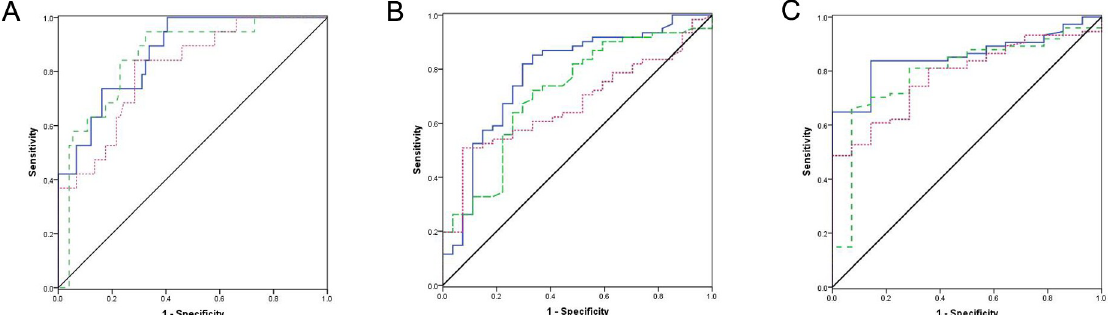
Fig 3. ROC plots express the prognostic value of illness severity of lymphopenia compared with CRP and LDH levels. ROC curves to predict patients with (A) pneumonia of severe grade or critical grade, (B) bilateral lung involvement in lung CT scan, and (C) abnormal lung image on discharge. The diagonal line indicates an AUC of 0.5 (no discrimination between the two states). The blue line indicates CRP level; The green dashed line indicates lymphocyte count; The pink dotted line indicates LDH level. LYM, lymphopenia; CRP, C-reactive protein; LDH, lactate dehydrogenase; AUC, area under the curve; ROC, receiver-operator curve.